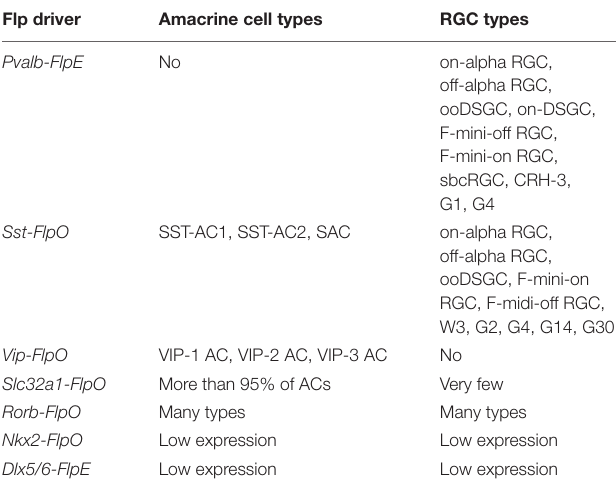
TABLE 2 | Summary of AC and RGC types in Flp drivers.